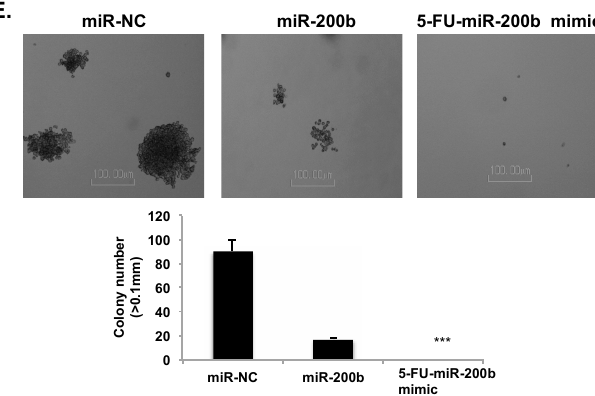
Figure 4. 5-FU incorporated miR-200b (5-FU-miR-200b mimic) showed enhanced therapeutic efficacy in TNBC cells. ( A ) Sequence of 5-FU-miR-200b mimic. All uracils in miR-200b were replaced with 5-FU. ( B ) MDA-MB-231 cells were treated with 30 μ M 5-FU or transfected with the indicated miRNAs. Cell lysates from each sample were used for western blot analysis. In left panel, 5-FU-miR-200b mimic was shown to maintain functional 5-FU activity by presence of FdUMP-TS complex (the upper shift-band). In right panel, the expression level of ZEB-1 and Fibronectin was detected by Western blot analysis. β -actin levels were used as loading control. ( C ) MDA-MB-231 cells transfected with the indicated miRNAs were stained with propidium iodidie (PI) and the percentage of cell population in each phase was analyzed by flow cytometry. Representative flow cytometry pattern images were selected from three independent experiments (left). The ratio was calculated on the right average values of 3 independent assays (right; bar graph). ( D ) The cell motility inhibitory ability of MDA-MB-231 cells transfected with the 5-FU-miR-200b mimic was measured using a transwell assay. The migration was quantified by counting the cells per square milliliter using bright-field optics. ( E ) MDA-MB-231 cells expressing miR-200b, 5-FU-miR-200b mimic and negative controls were cultured in soft agar containing growth medium after 10 days. Colony formation was captured at 10× or 20× magnification. Only cell colonies >0.1 mm in diameter were counted. Representative images were carried out at least 3 times. All data are presented as the means ± SD. *, p < 0.05, **, p < 0.01, ***, p < 0.001.